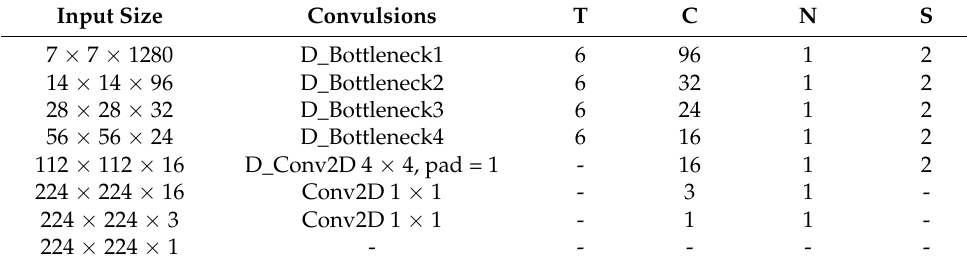
Table 2. Expansion